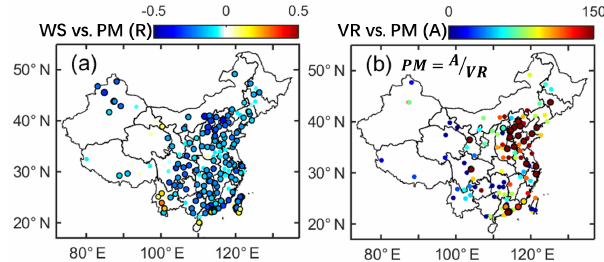
Figure 11. (a) Spatial distribution of linear correlation coefficients ( R ) for the WS–PM 2 . 5 relationship. (b) Spatial distribution of fit- ting parameter ( A ) for the VR–PM 2 . 5 relationship. The function PM 2 . 5 = A/ VR is used to characterize the relationship between VR and PM 2 . 5 , with A (unit: kmµgm − 3 ) as the fitting parameter. Both WS and PM 2 . 5 are obtained from surface data, and PBLH is derived from CALIPSO. Here and in the following analysis, dots marked with black circles indicate where the relationship is statistically sig- nificant at the 99% confidence